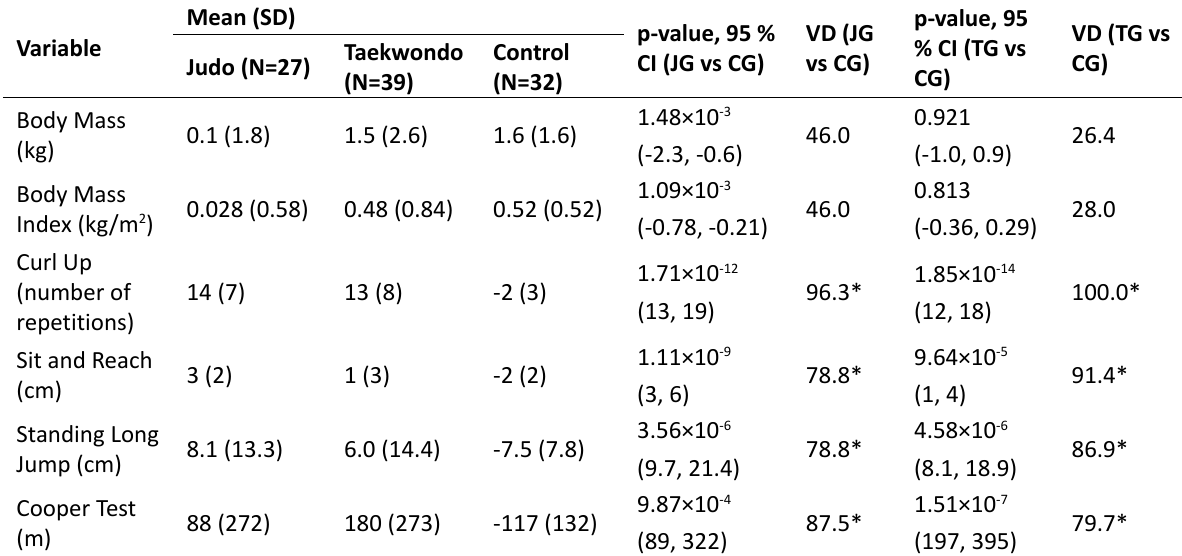
Table 3. Differences in the changes from baseline to post